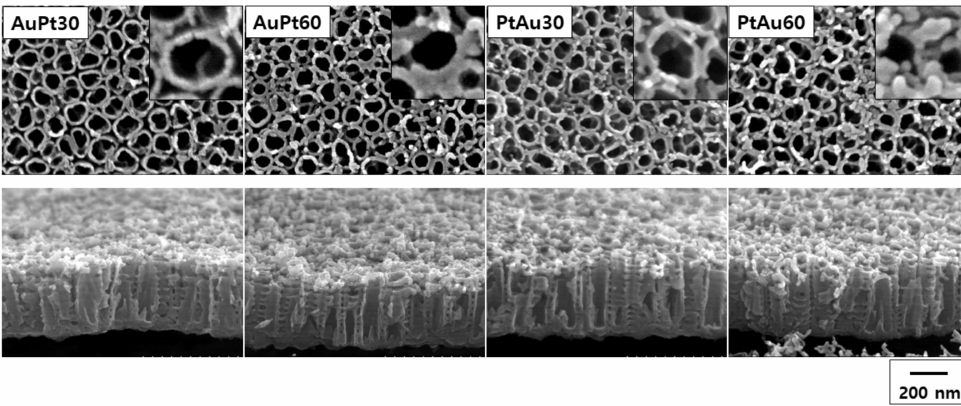
Figure 1. FE-SEM characterization of AuPt-TiO 2 nanotubes and PtAu-TiO 2 nanotubes (AuPt30 and AuPt60; 30 and 60 s of Au and Pt sputtering in this order, PtAu30 and PtAu60; 30 and 60 s of Pt and Au sputtering in this order, respectively) (top: plain view, bottom: oblique view, inset: magnified plain